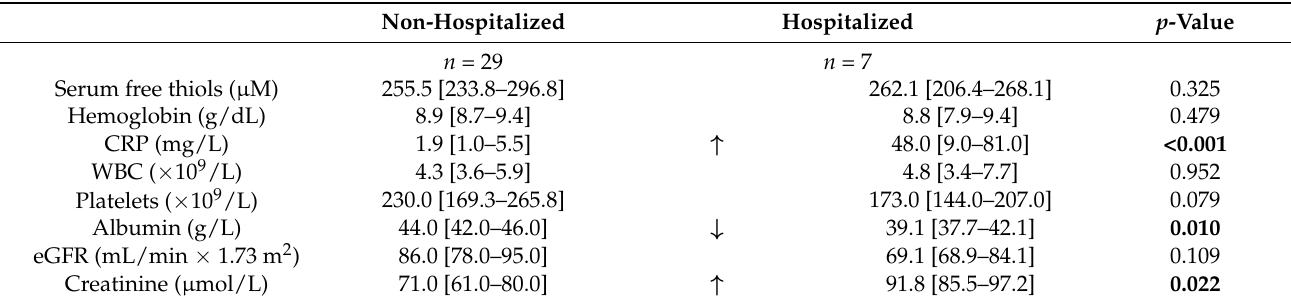
Table 4. Serum free thiol concentrations and other laboratory measurements in non-hospitalized COVID-19 subjects and COVID-19 subject who eventually required